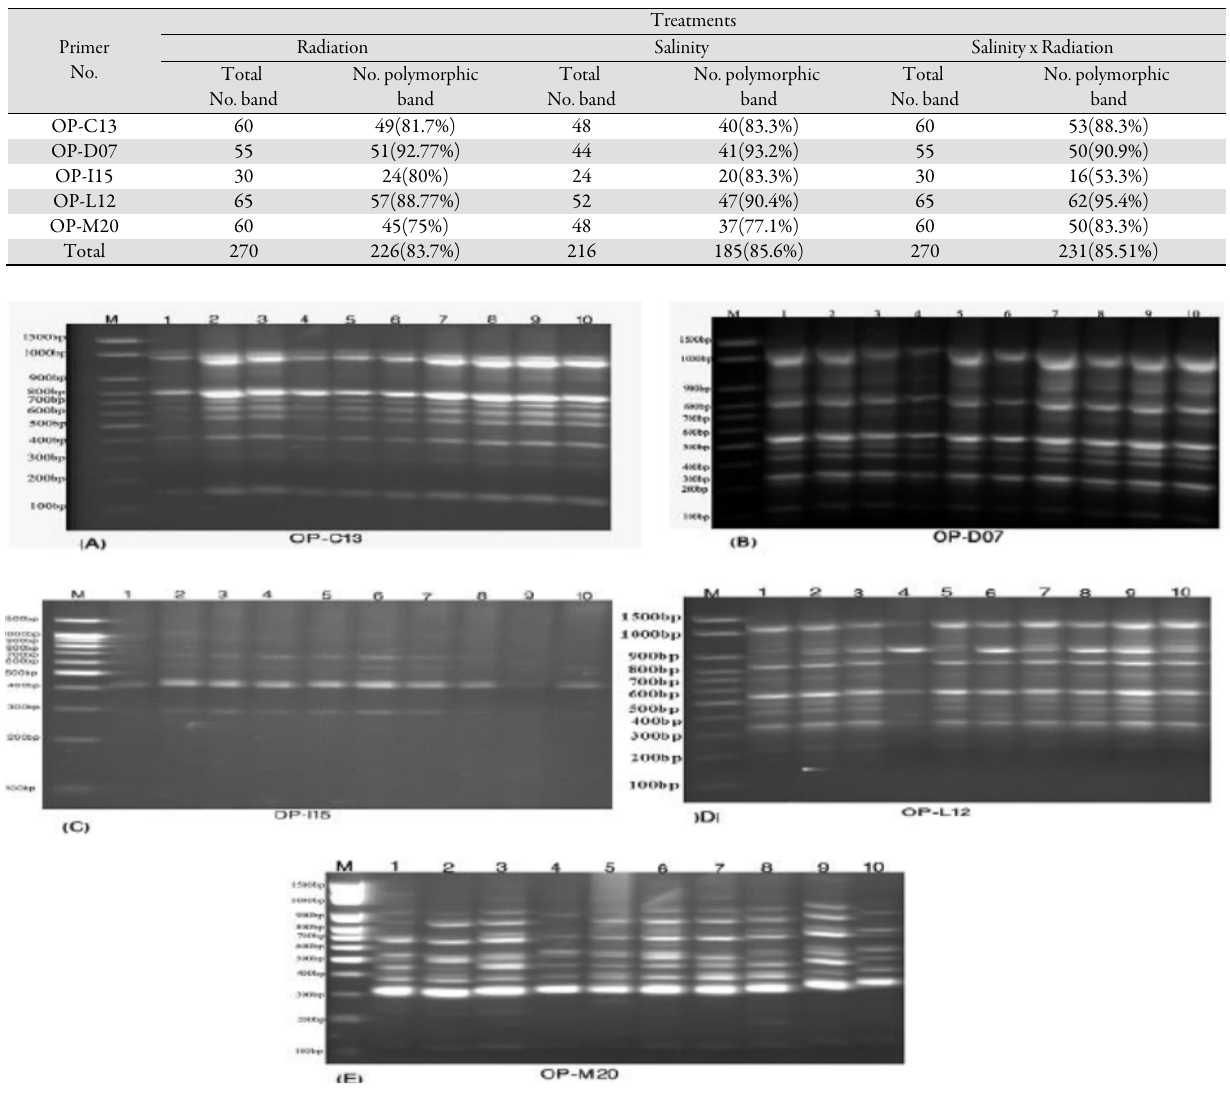
Fig. 3. Representative RAPD profile of treated haploid Nicotiana alata . Lane 1 Cont. diploid; Lane 2 Cont. haploid; Lane 3 Irradiated haploid 15 Gy; Lane 4 Irradiated haploid 20 Gy; Lane 5 Irradiated haploid 25 Gy; Lane 6 haploid Grew on 150 mM; Lane 7 haploid grew on 200 mM NaCl; Lane 8 haploid 20 Gy X 50 mM NaCl; Lane 9 haploid 20 Gy X 100 mM NaCl; Lane 10 haploid 25 Gy 50 X 50 mM NaCl.